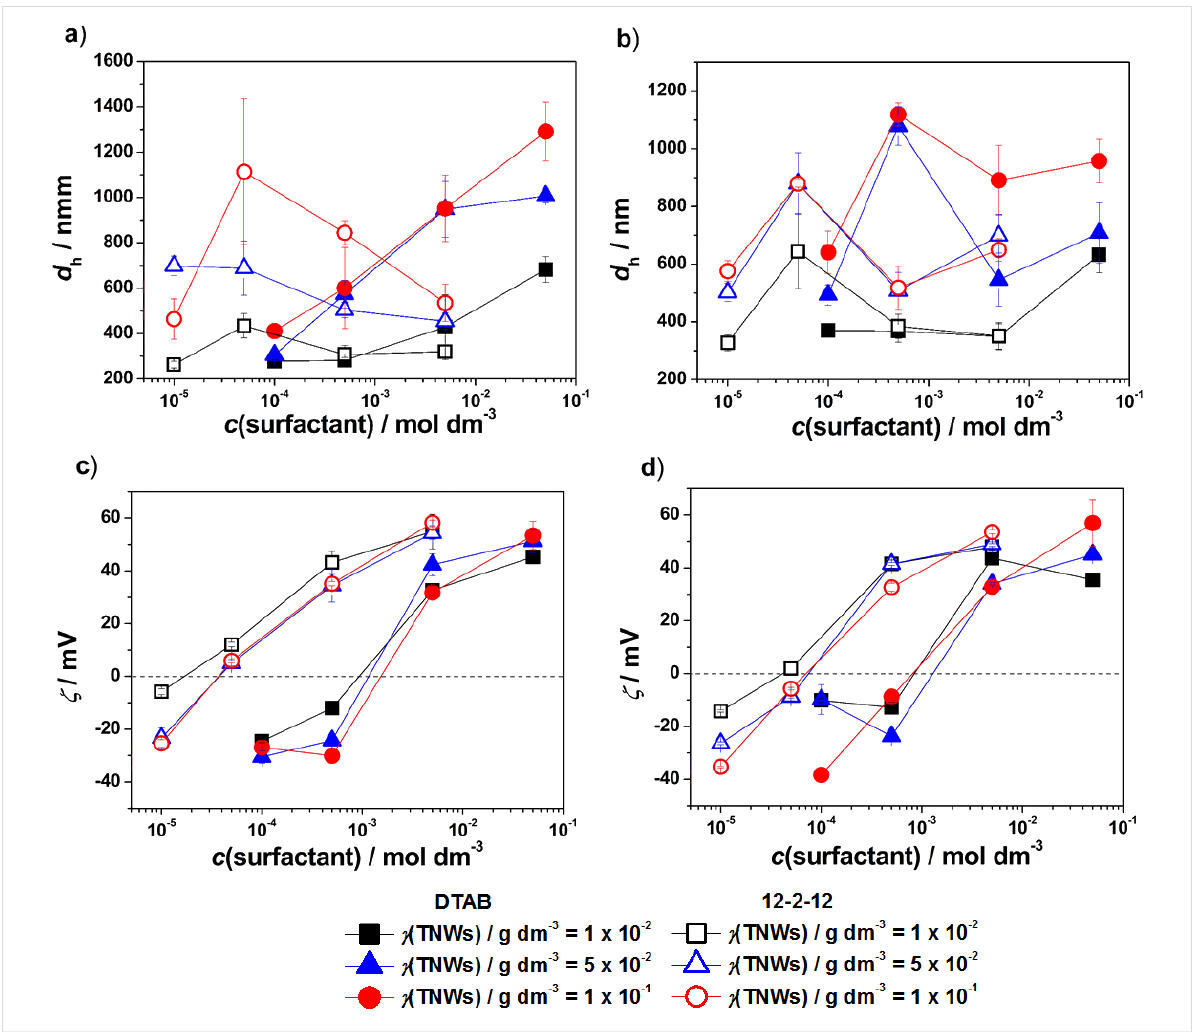
Figure 5: The comparison of d h obtained for TNW/surfactant systems in Milli-Q water (a) and 1 × 10 − 3 mol dm − 3 NaBr (b) and the zeta potential ( ζ ) in Milli-Q water (c) and 1 × 10 − 3 mol dm − 3 NaBr (d) after 24 h. θ = 25 °C. The lines connecting the data points are a guide for the eye.